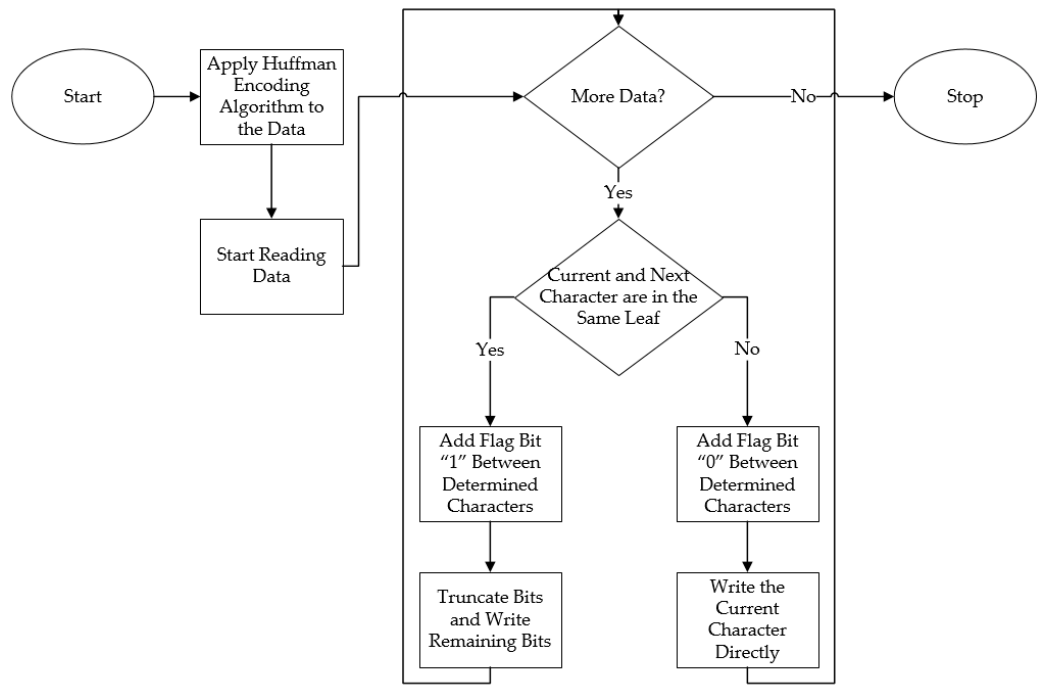
Figure 9. Flowchart of proposed encoding algorithm.